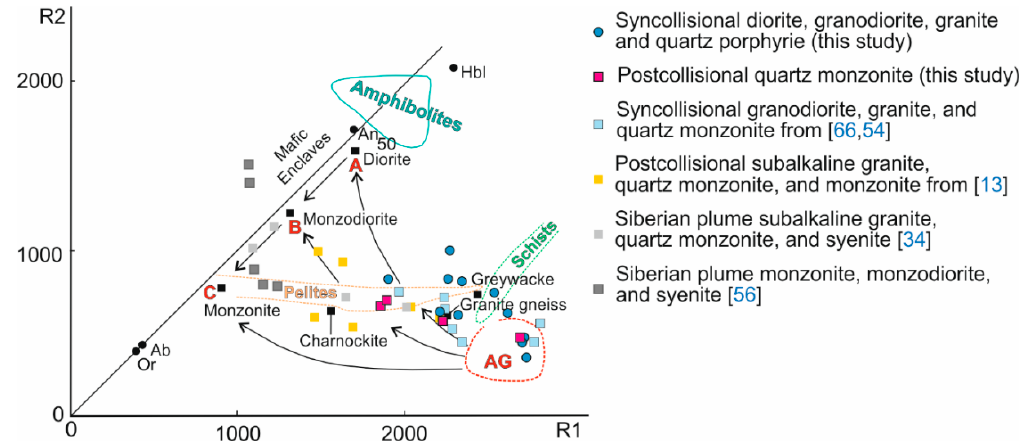
Figure 17. Petrogenetic discrimination diagram R1–R2 for the studied felsic rocks after [103]. R1 = 4Si – 11(Na + K) – 2(Fe + Ti); R2 = 6Ca + 2Mg + Al. Components present in cationic proportions. AG—zone of anatectic granitic melts. The vectors AG-A, AG-B and AG-C indicate the change in melt composition under progressive equilibrium partial melting of rocks of dioritic, monzodioritic or monzogranitic bulk composition, respectively (Hbl—Hornblende; An 50 —Plagioclase (An 50 ); Ab—Albite; Or—Orthoclase). Black squares are central compositional points of imaged rocks. Metasedimentary rocks and amphibolites compositions are from [104].